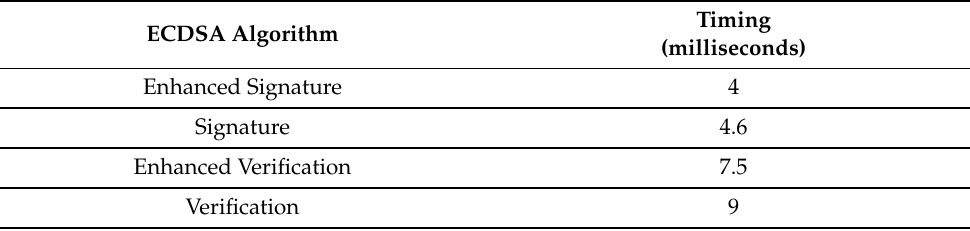
Table 3. Timing comparison between a lightweight ECDSA implementation and our enhanced version of